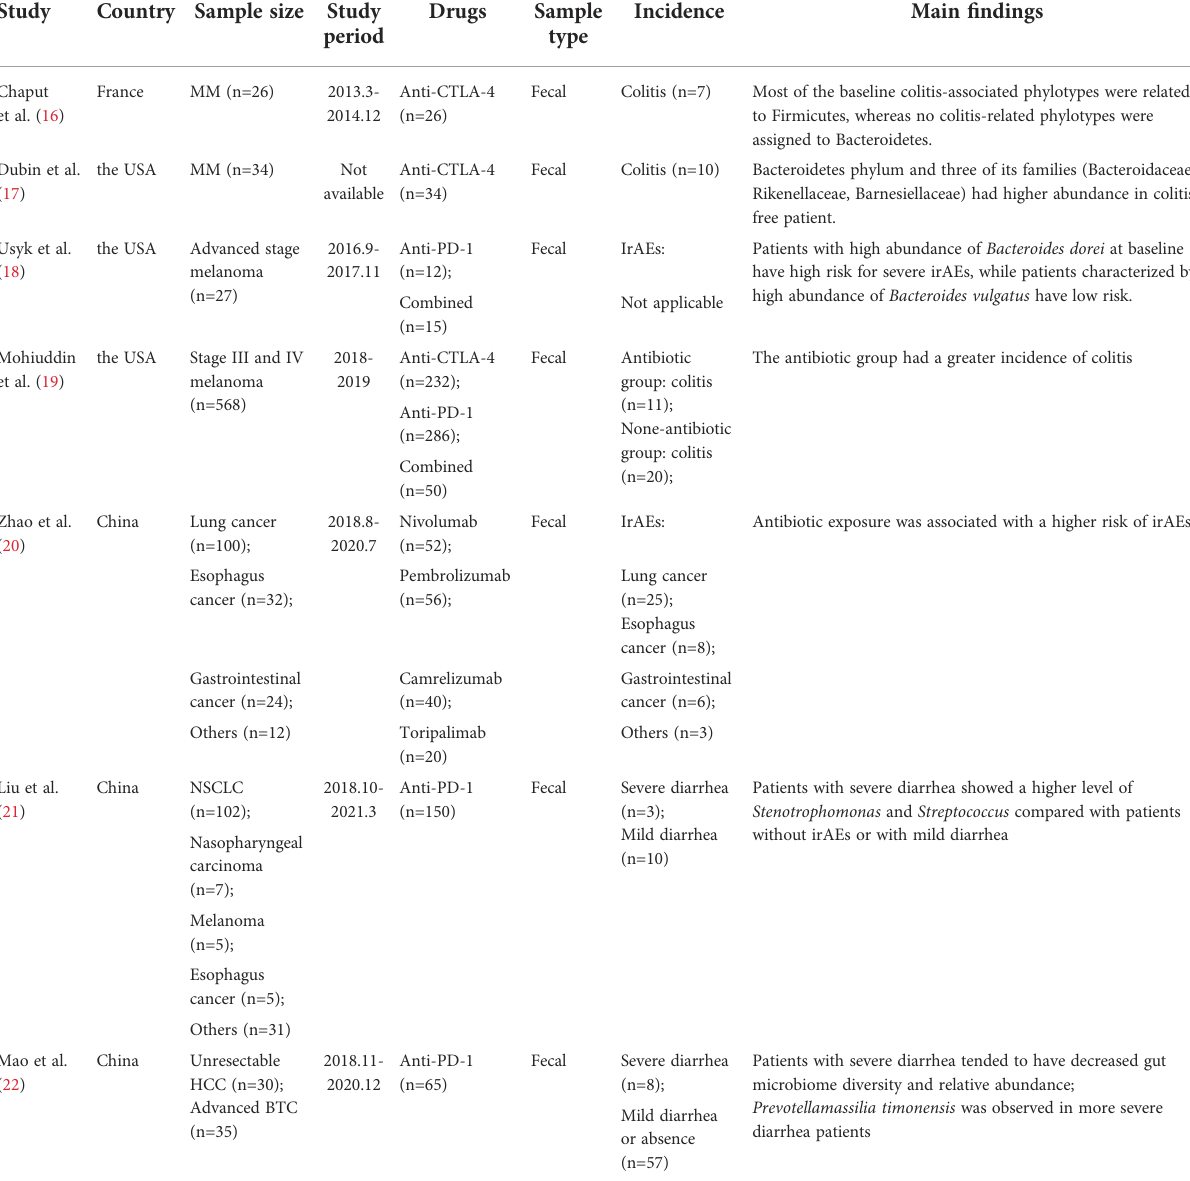
TABLE 1 Gut microbiota studies for immune checkpoint inhibitor-related colitis and other